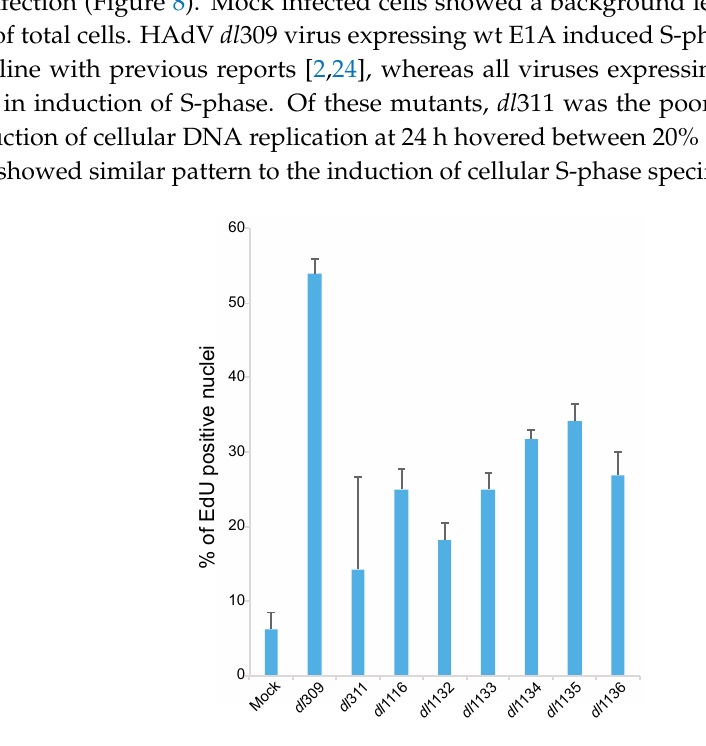
Figure 8. C-terminus of E1A is important for induction of DNA replication in arrested WI-38 cells. Arrested WI-38 cells were infected with the indicated viruses at a MOI of 100 for 23 h, pulsed with EdU for 1 h, fixed and stained for EdU using the Click-It EdU labeling kit. Cells were also labeled for E1A using the M58 antibody and anti-mouse Alexa594-conjugated secondary antibody. Cellular nuclei were also counterstained using DAPI. All mutants were significantly different from dl 309 with a p ≤ 0.0341. Error bars represent standard deviation of biological replicates, n = 5.